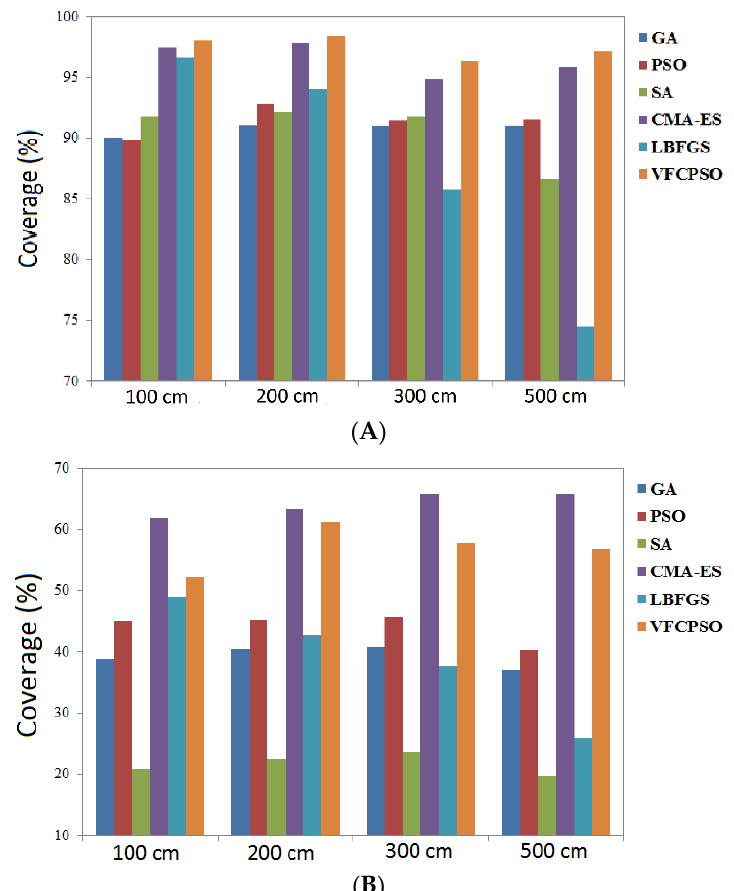
Figure 17. Comparison of final vector coverage of each of global optimization algorithms: ( A ) two-dimensional model; and ( B ) three-dimensional model.